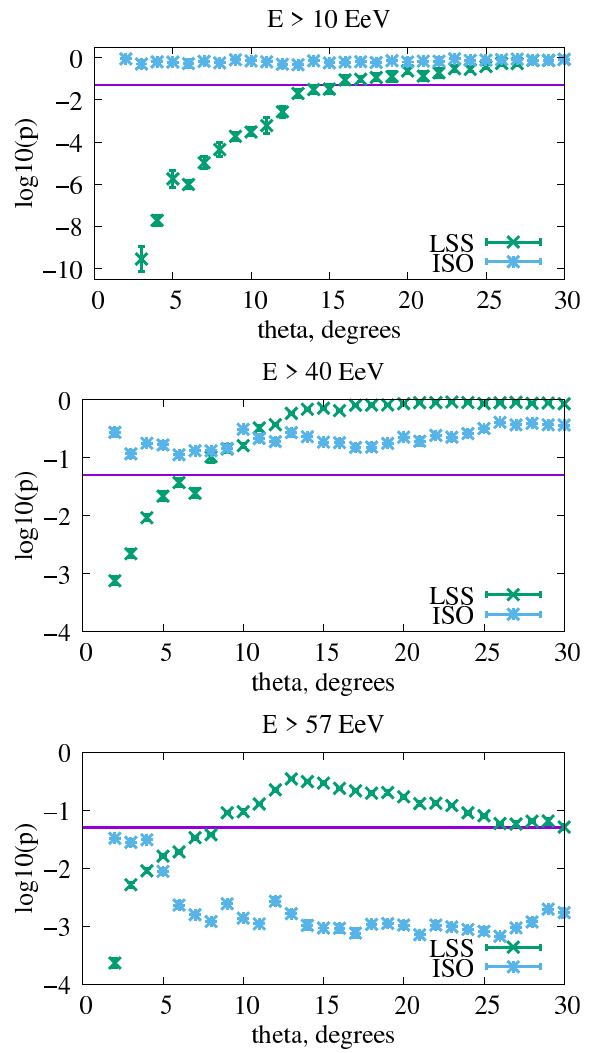
Figure 1. Compatibility between UHECR events observed by the TA for 10 years and two di ff erent models which are the flux model of the LSS hypothesis (blue points) and the isotropic hy- pothesis (green points). Three plots show compatibility for en- ergy thresholds of 10 EeV, 40 EeV, and 57 EeV, respectively. The horizontal red line indicates a 95% confidence